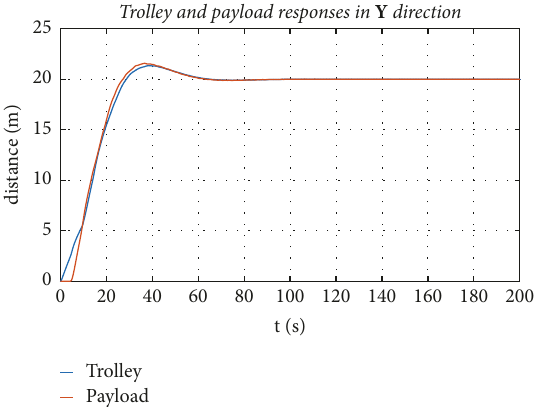
Figure 4: Trolley and payload responses in Y direction without vibration control.